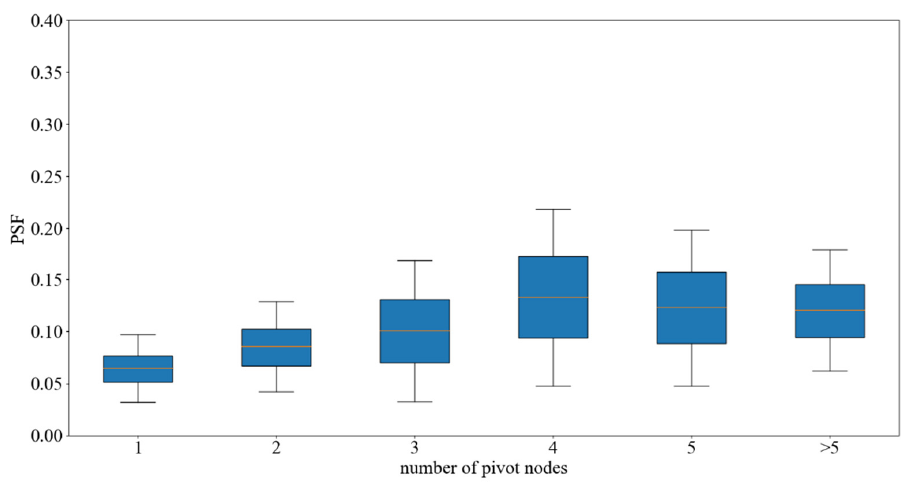
Figure 12. Boxplot of the number of central nodes regarding the PSF.